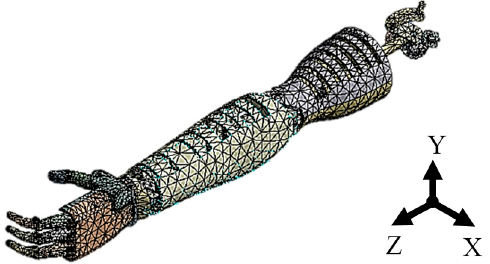
Figure 2. Discretized model.